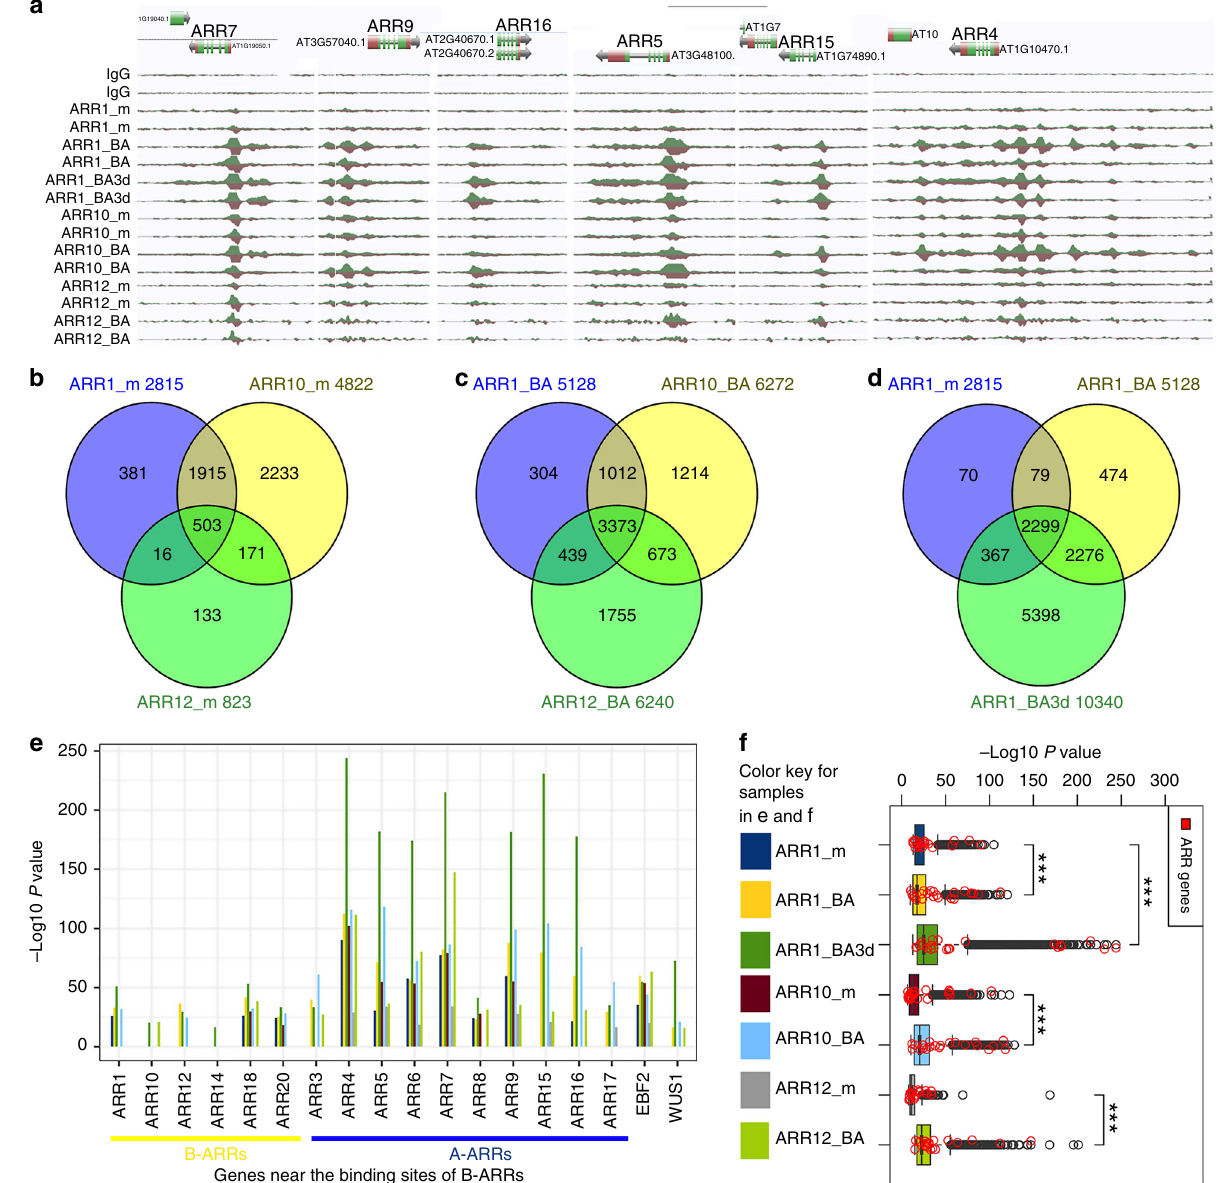
Fig. 3 A-ARR s are direct targets of B-ARR transcription factors. a AnnoJ browser snapshots of A-ARR genes, targets of B-ARR TFs. b Venn diagram describing the number of target genes for each of three key B-ARRs in the mock treatment (m). c Venn diagram describing the number of target genes for each of three key B-ARRs in the 10 µ M 6-BA 4-h treatment (BA). d Venn diagram describing the number of target genes increase for ARR1 in a cytokinin time course treatment, 0 h (m), 4 h (BA), 3 days (BA3d). e Peak scores ( − Log10 p- value) of ARRs in various cytokinin treatments. f Box plot showing the distributions of the binding peak scores of B-ARR targets. ARRs were highlighted in red circles. Asterisks (***) indicates signi fi cant difference using Wilcoxon rank-sum test ( p < transcriptional gene regulatory network (Fig. 2d, Supplementary Data 6), providing a framework for future studies of cytokinin response genes. A negative feedback loop in the cytokinin regulatory network . Previous indirect evidences including genetic studies, transcrip- tional pro fi ling results, and promoter deletion analyses of A-ARRs suggested that these genes are targets of B-ARRs 20,34,35 . Our results show signi fi cant increase of B-ARR binding to the promoter of A-ARRs in response to cytokinin (Fig. 3a) and A-ARR genes are among the top-ranking targets of multiple